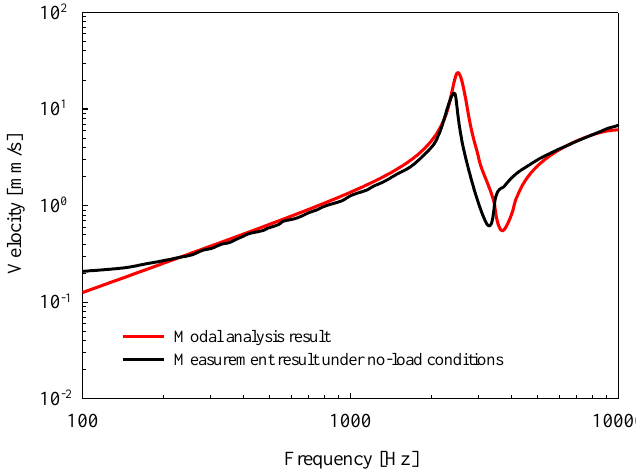
Figure 7. Comparison of vibrational characteristics between the implemented piezoelectric actuator (black solid line), and the results of the modal analysis (red solid line) under no-load conditions.